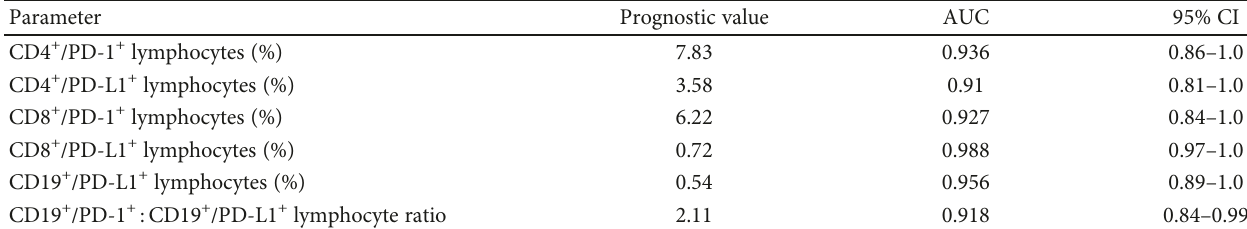
Table 2: ROC analysis to determine diagnostic accuracy of immunological parameters in endometriosis